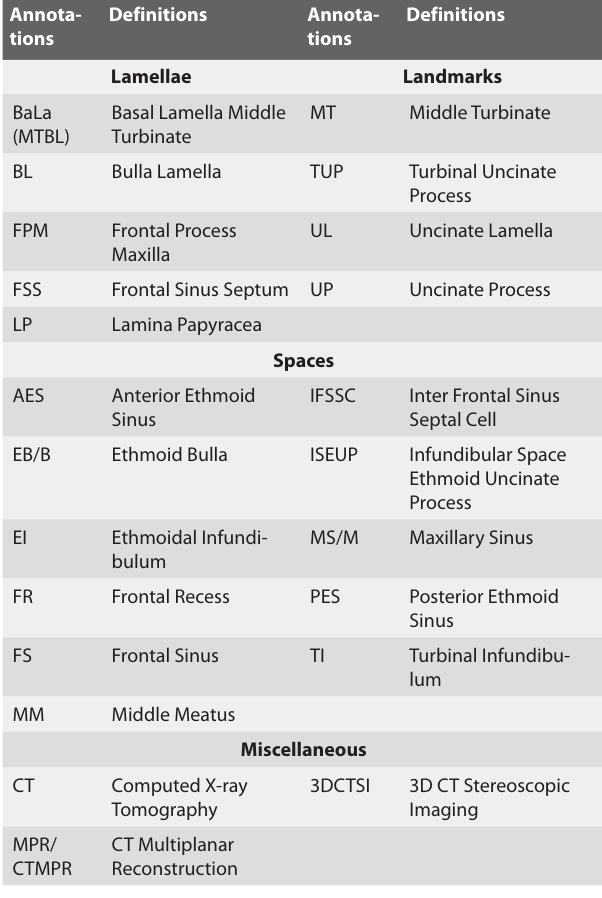
Table 1. List of